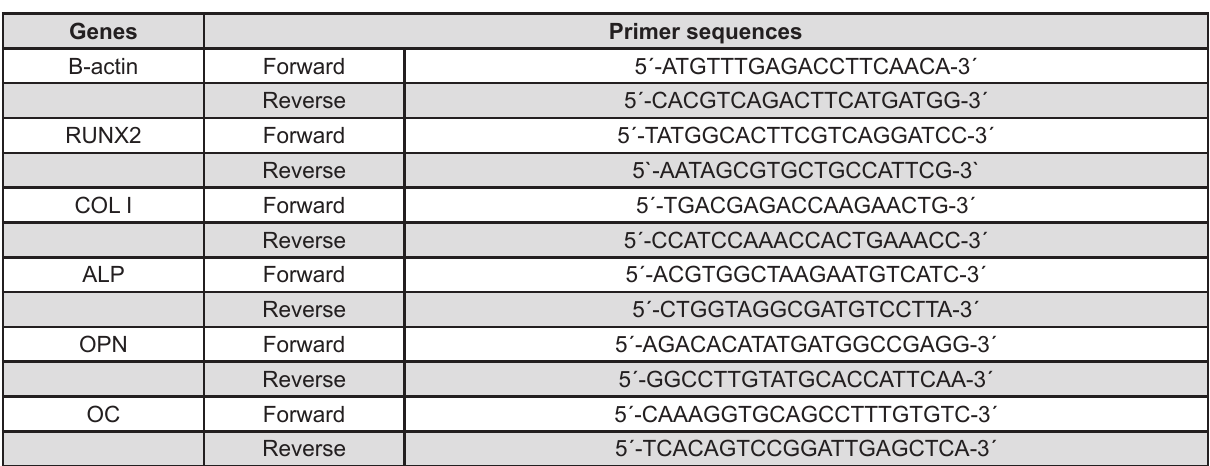
Figure 1- Primer sequences for real-time polymerase chain reaction